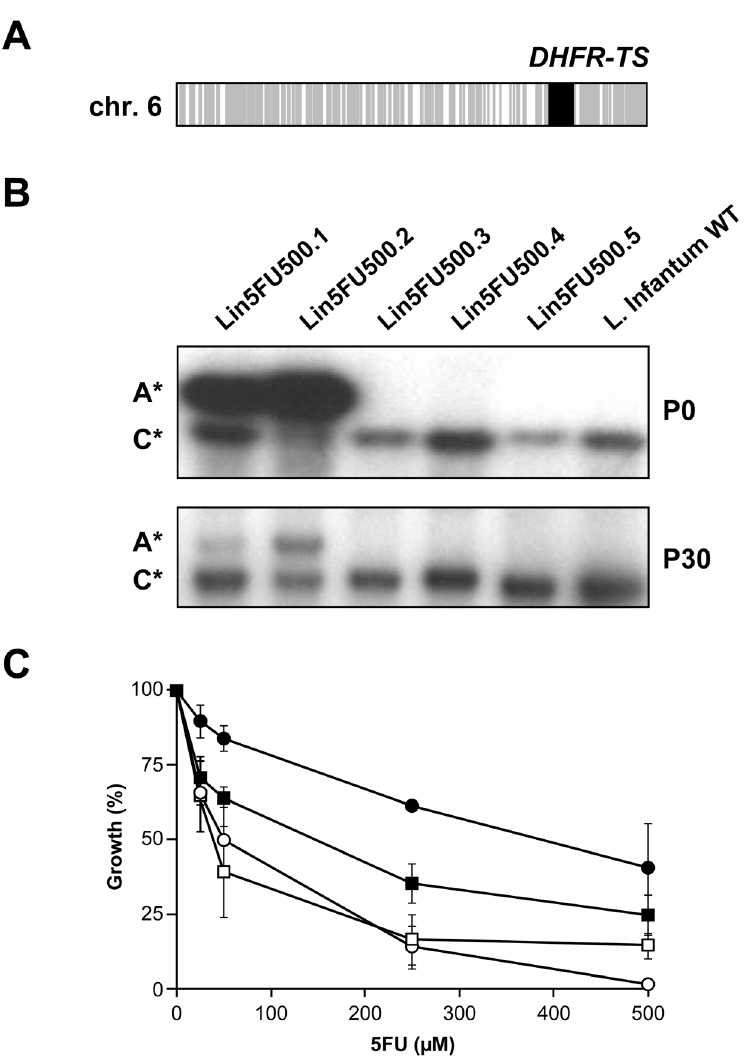
Figure 1. DHFR-TS amplification and resistance to 5-fluorouracil. ( A ). Comparative genomic hybridization (CGH) experiments between wild- type and Lin5FU500.2 cells. Grey, equal amount of DNA between the two strains; black, increased copy number of DNA in the mutant Lin5FU500.2. ( B ). Southern blots of total digested DNAs isolated from WT and each mutant strains at 0 and 30 passages without drug were hybridized to a specific DHFR-TS probe. The DNA was digested to discriminate the chromosomal copy (C*) from the amplified copy (A*). ( C ). Role of DHFR-TS in 5-FU resistance. Growth curves of wild-type L. infantum parasites transfected with the expression construct pSP72 a HYG a - DHFR-TS (black squares) or with the empty vector pSP72 a HYG a (white squares) or the Lin5FU500.2 revertant transfected with pSP72 a HYG a - DHFR-TS (black circles) or pSP72 a HYG a (white circles). Average of at least three independent experiments. Transfection of DHFR-TS led to 5FU resistance that was statistically significant compared to mock transfectants (p , 0.05).